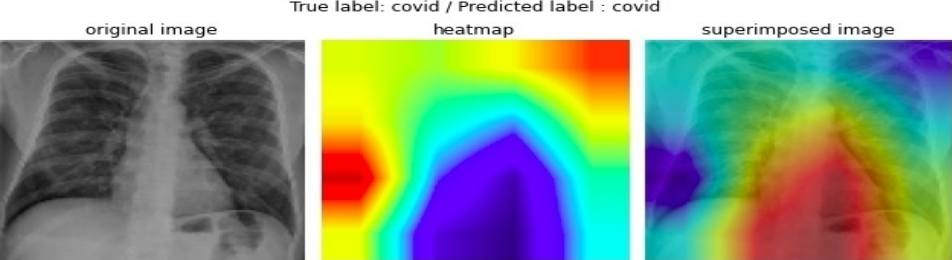
Figure 11. Heap map and super imposed image for the study of pulmonary amalgamation .